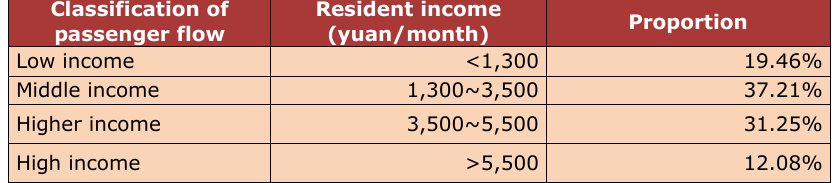
Table 1. Economic structure of passengers in Nanchang-Jiujiang transport corridor